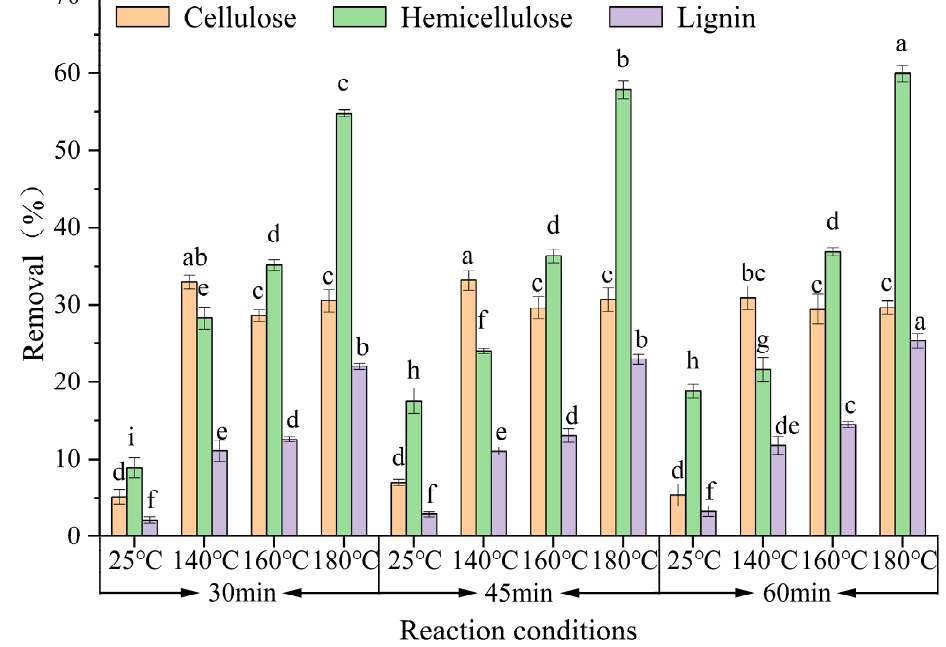
Figure 4. The effect of different HTE conditions on the percentage removal of lignocellulose from BW in the second stage. The alphabets on the bar graph indicate statistical difference ( p < 0.05).